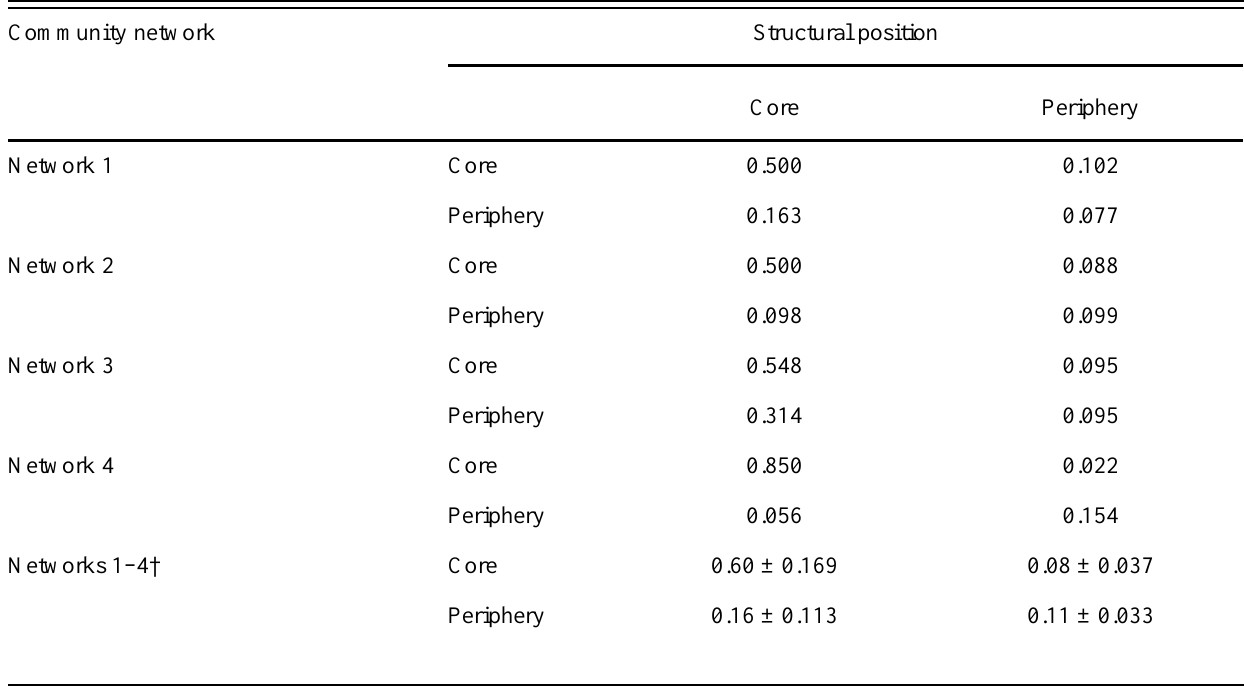
Table 2. Density of farmer ties in each position-to-position interaction, i.e., core to core, core to periphery, periphery to core, and periphery to periphery, for four community networks and averaged over the four